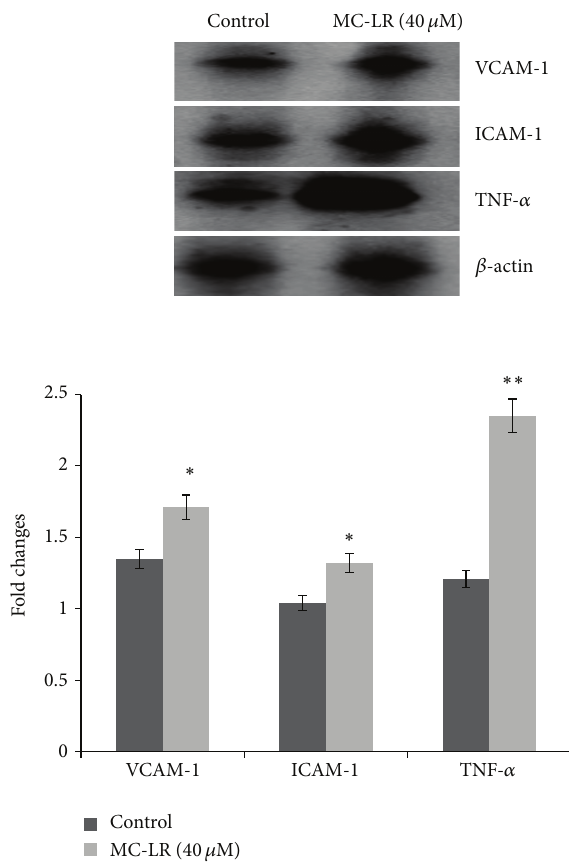
Figure 7: The MC-LR induced the expression of VCAM-1, ICAM-1, and TNF- 𝛼 protein in